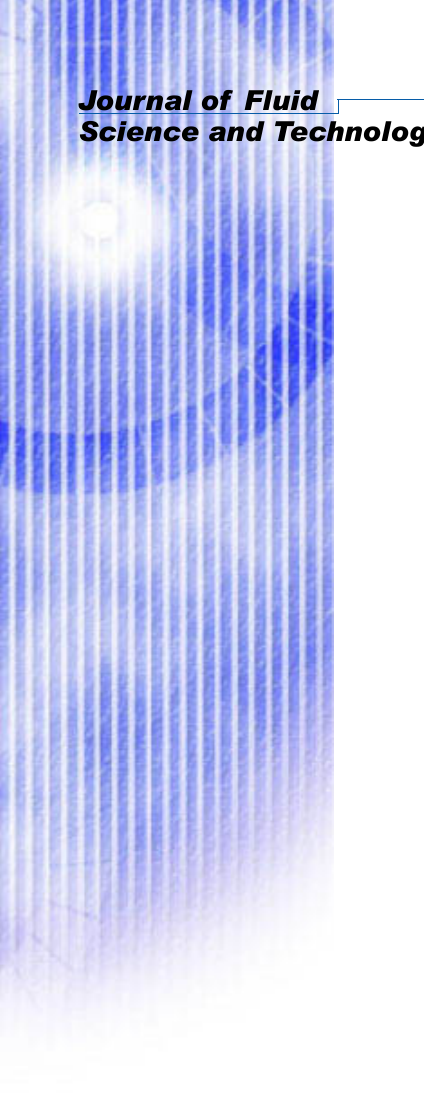
(b) Pattern 4(a) Pattern 3